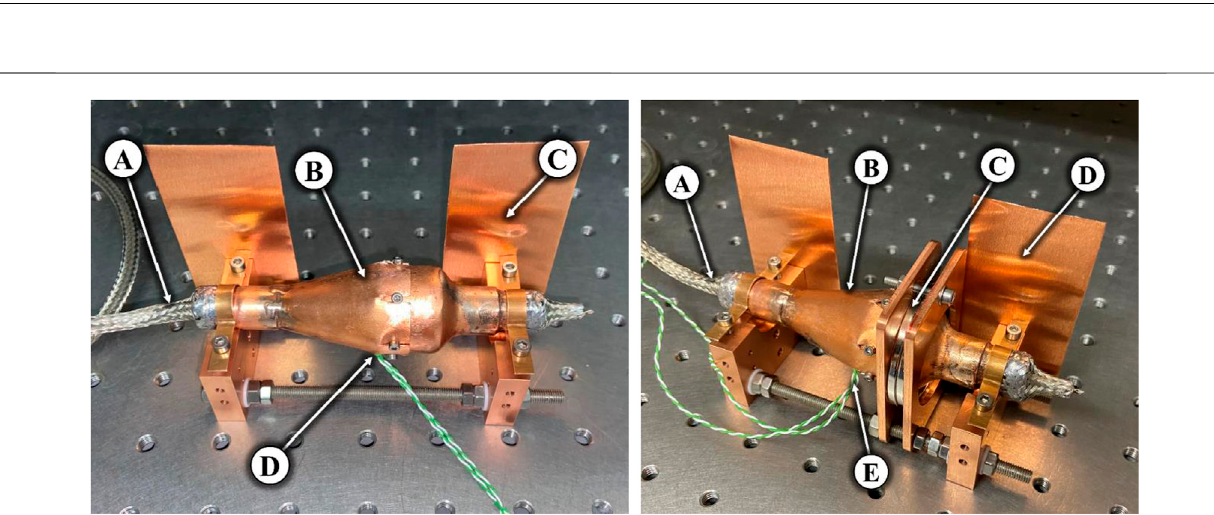
Frontiers in Physics |